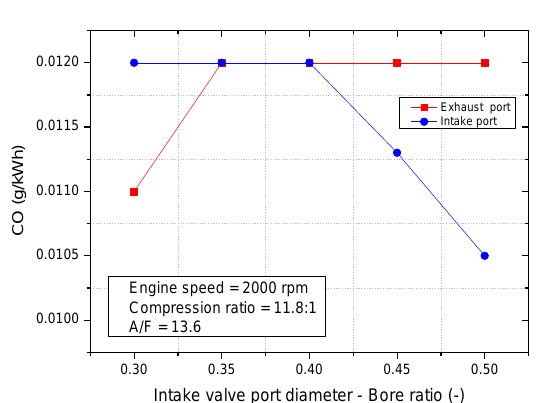
Figure 22. CO emission versus VPD/B.